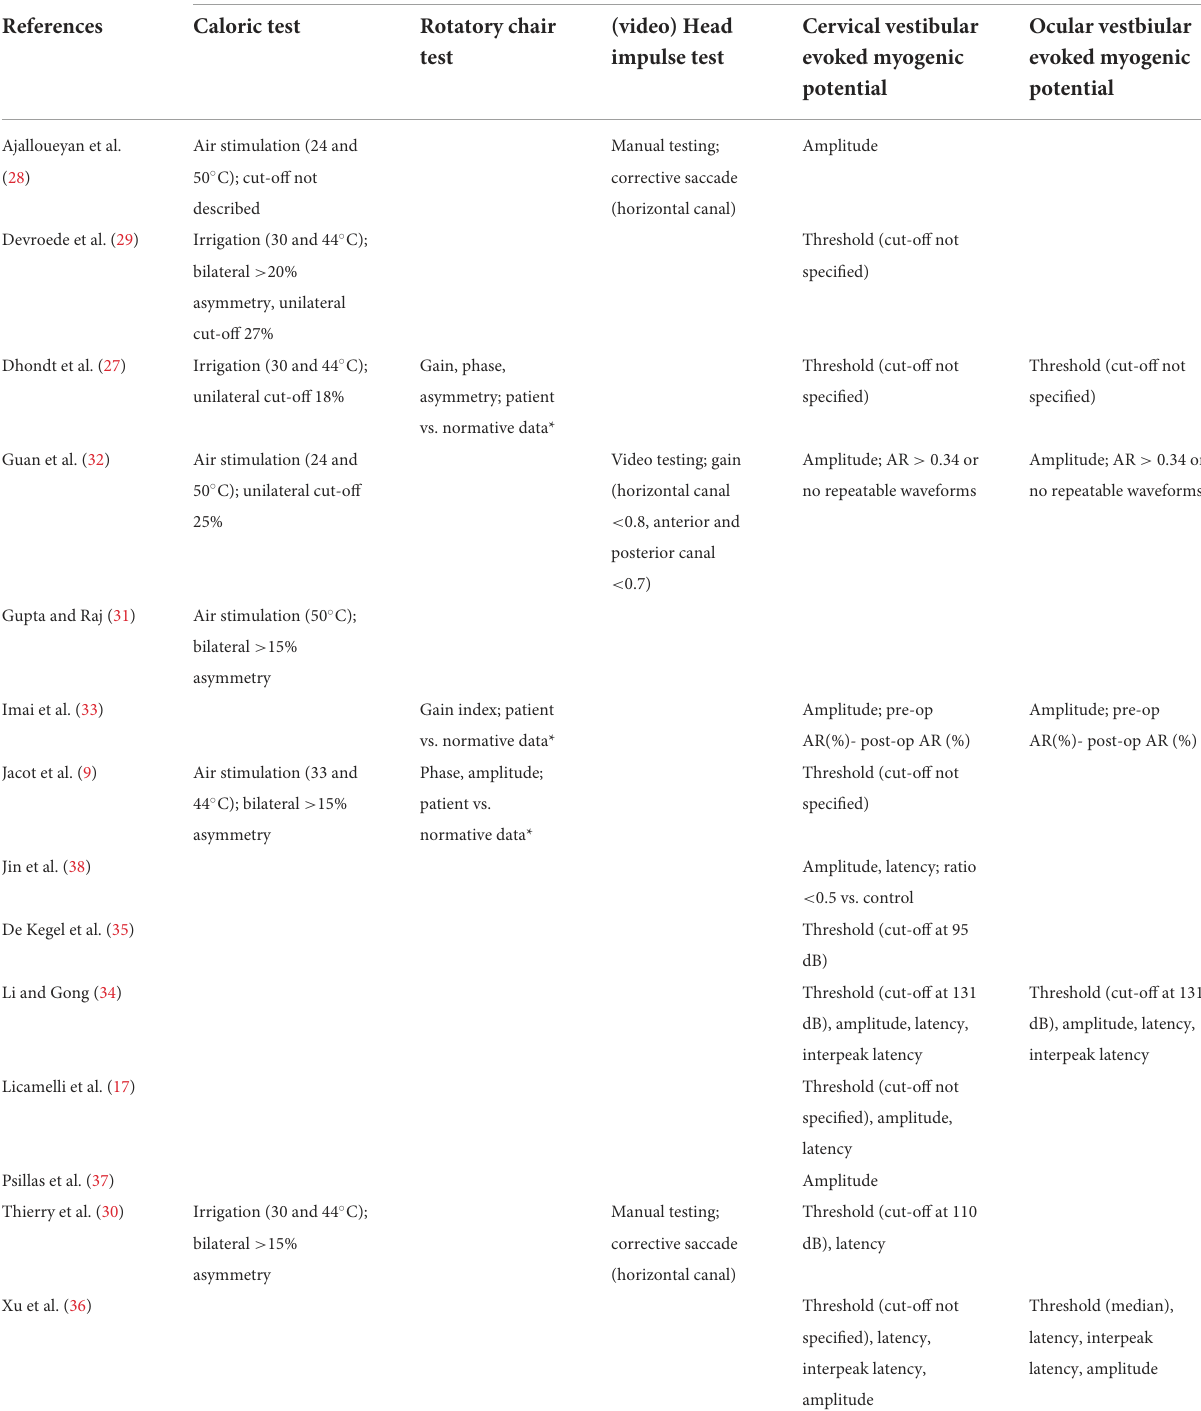
TABLE 2 Type of measurements and applied models to determine alterations in vestibular test